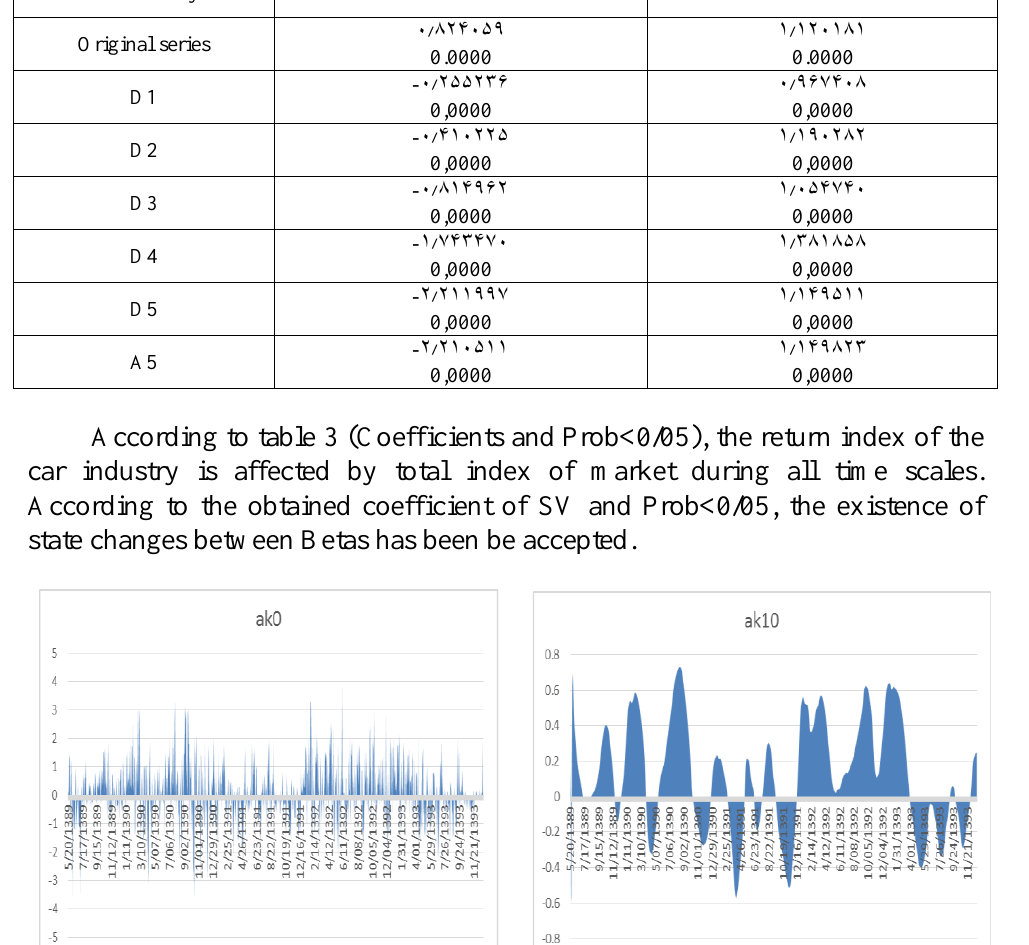
Table 3. Extracted coefficients from State-Space Model for car industry Car industry Coefficient of total index & Prob